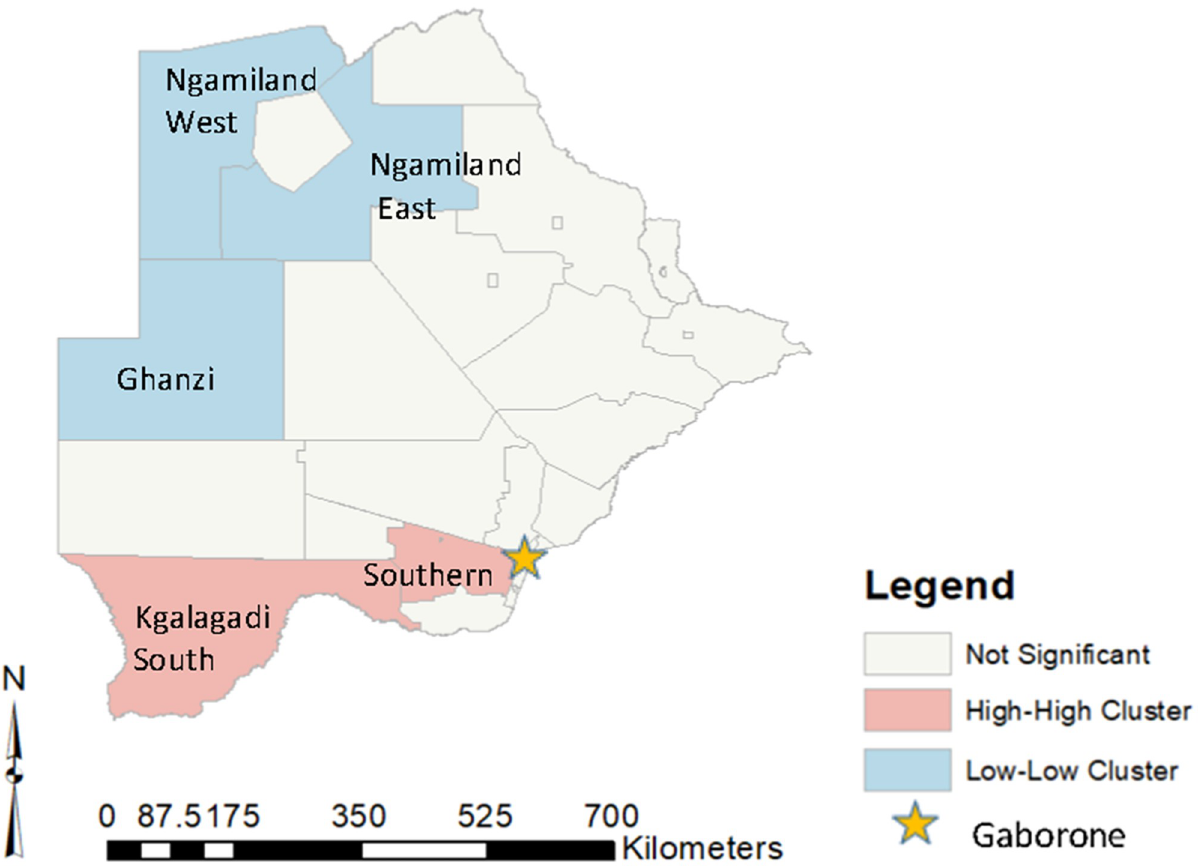
Fig 2. Identified High-High and Low-Low sub-district clusters � . � created in ArcGIS version 10.6.1 (Esri, Redlands, CA).